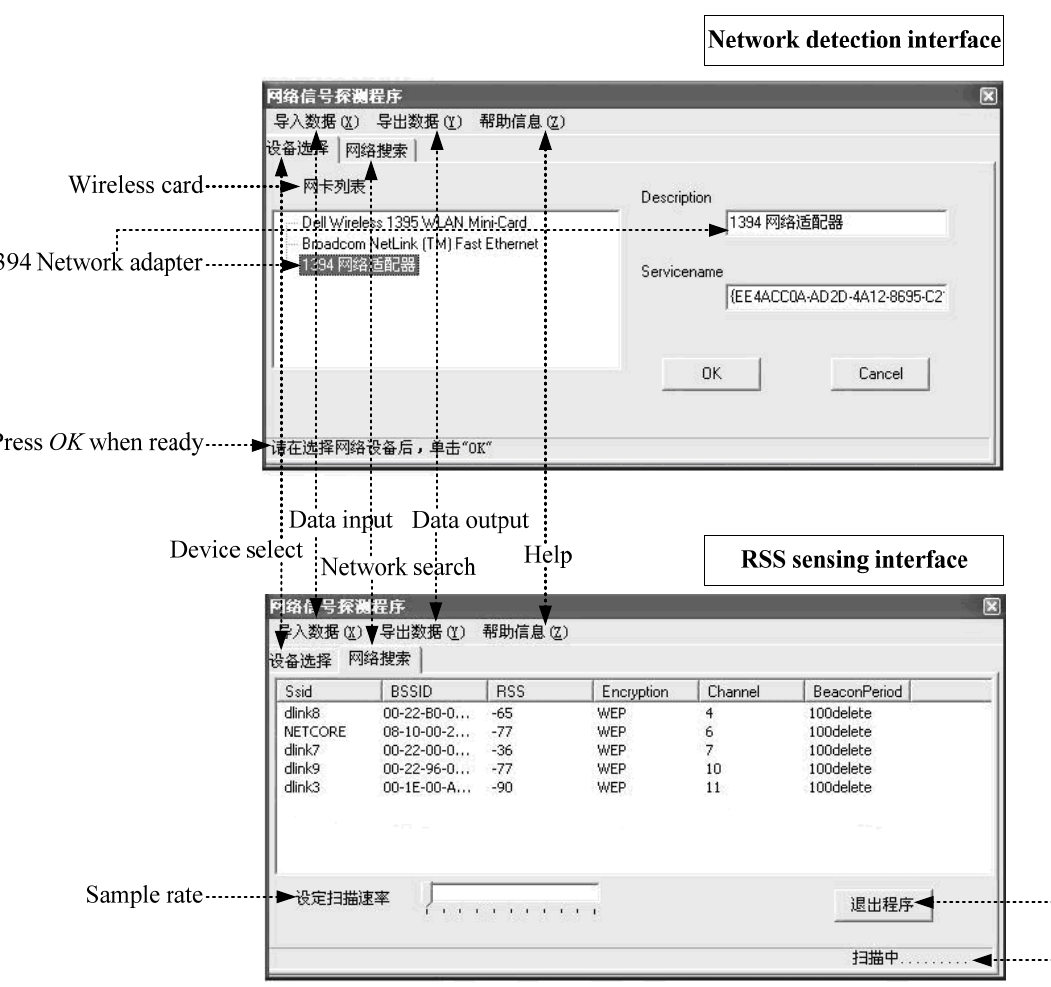
Figure 15. “HITWLAN v1.0” RSS sensing